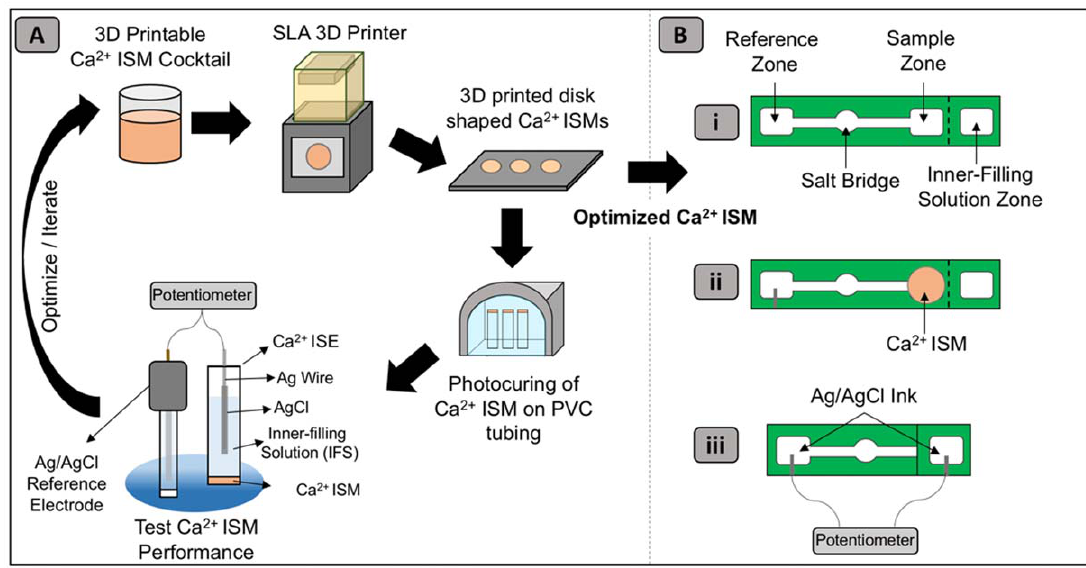
Figure 1. (A). A schematic representation of the 3D printing process for fabricating Ca 2 + -ISMs. An iterative process can be used to rapidly optimize the ISM composition for the fabrication of LC-ISE. (B). A schematic illustration of a Ca 2 + paper-based device. (i) a descriptive schematic of a wax printed paper device.